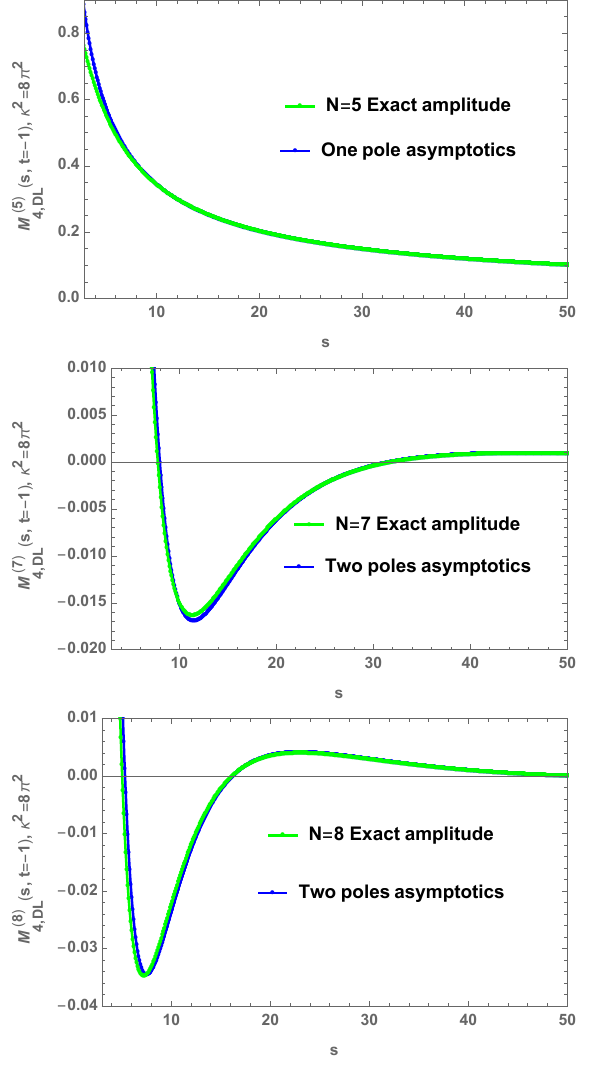
Figure 8 . A comparison of the DL exact amplitudes with their asymptotic estimates for di(cid:11)erent supergravities with N = 5 ; 7 ; 8 as a function of s with (cid:20) 2 = 8 (cid:25) 2 and t = (cid:0)